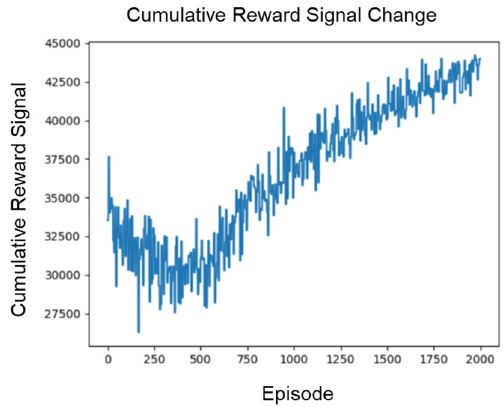
Figure 13. Cumulative reward signal obtained during training.